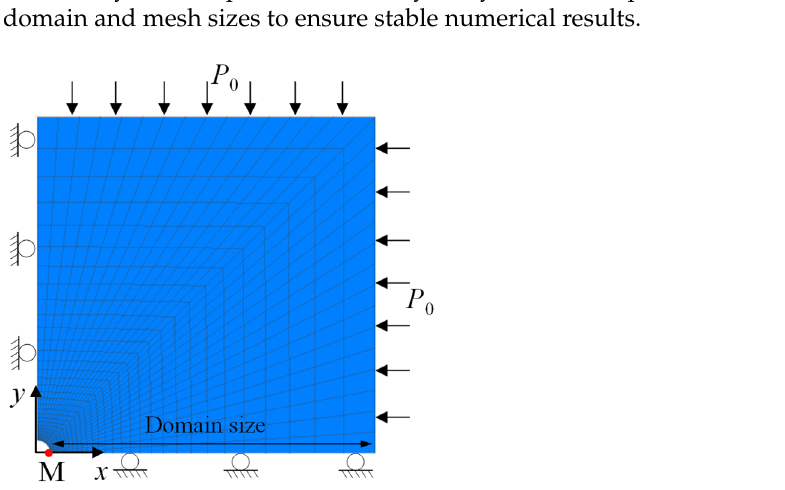
( b ) Figure A9. Variations of ( a ) radial displacement and ( b ) tangential stress at point M as functions of mesh size. The optimal domain and mesh sizes are then used to conduct numerical simulations of the problem. Figure A10 shows the comparisons between the numerical results of stresses and radial displacement long x ‐ axis with the analytical solutions. The good agree ‐ ments between the numerical and analytical results indicate that the FLAC 3D is validated.